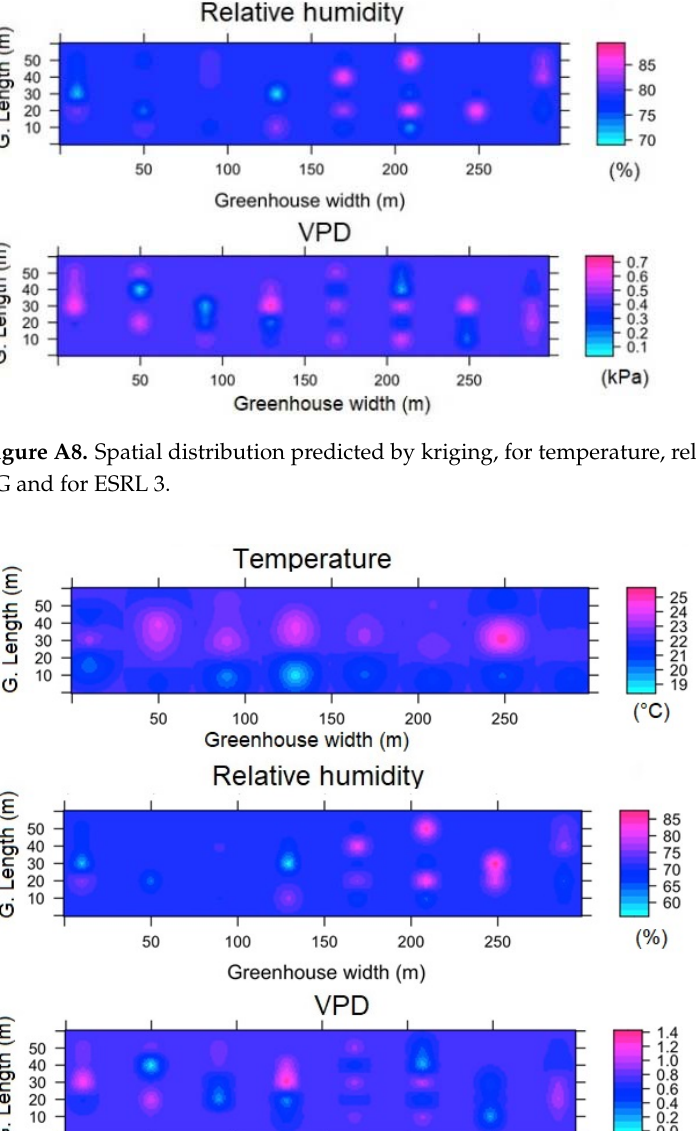
Figure A9. Spatial distribution predicted by kriging, for temperature, relative humidity and VPD in SG and for ESRL 4.